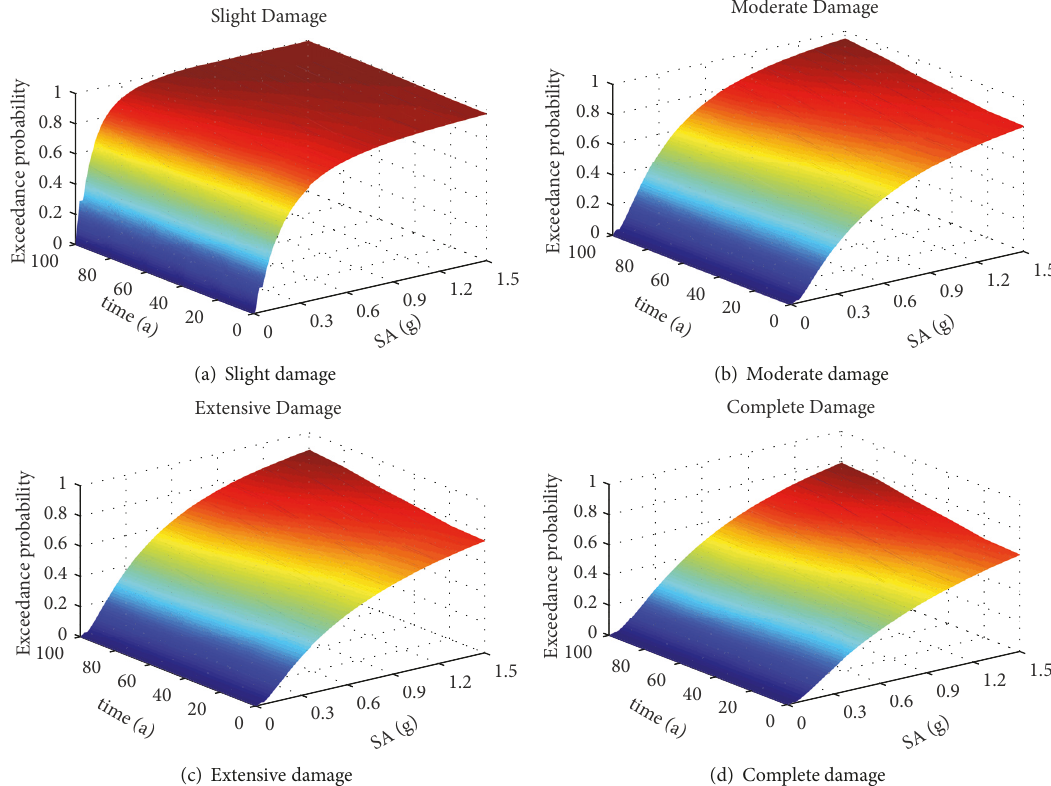
Figure 20: The vulnerability surfaces of 5 # bearing under different damage